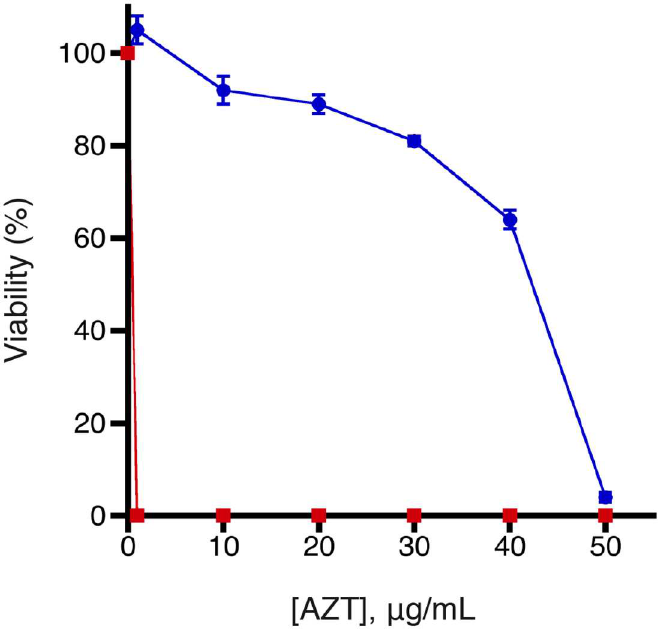
Fig 3. Viability of E . coli BW14012 cells expressing tatHSV-TK (blue circles) or tatHSV-TKD (red squares) as a function of AZT concentrations. Cell viability is expressed relative to the number of coloniesat 0 μ g/mL AZT for each strain